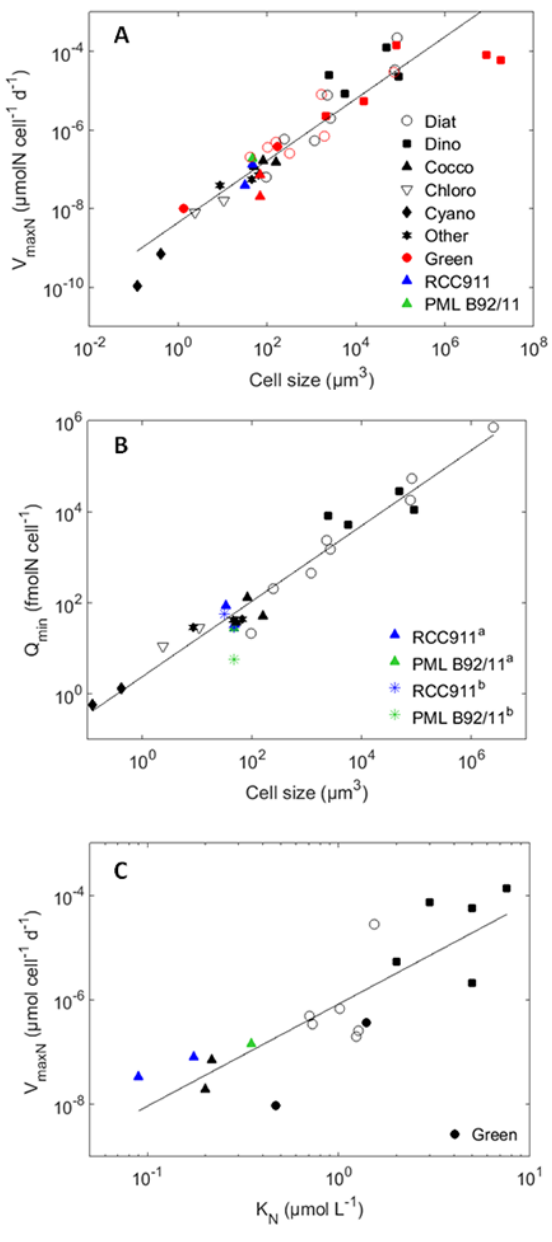
Figure 7. (a) Maximum normalised surface uptake rate V maxN for nitrate vs. the cell volume. Data from Marañón et al. (2013) in black, data from Litchman et al. (2007) in red and the Droop model output for the experiments presented in this work in blue and green de- pending on the strain. (b) Minimum cellular quota Q min for nitrate vs. the cell volume. Data of Marañón et al. (2013) and the results from the model and analysis of the present study. (c) V maxN vs. the half-saturation constant for nitrate uptake K N . Data of Litchman et al. (2007) and results from the Droop model in nitrate-limited con-